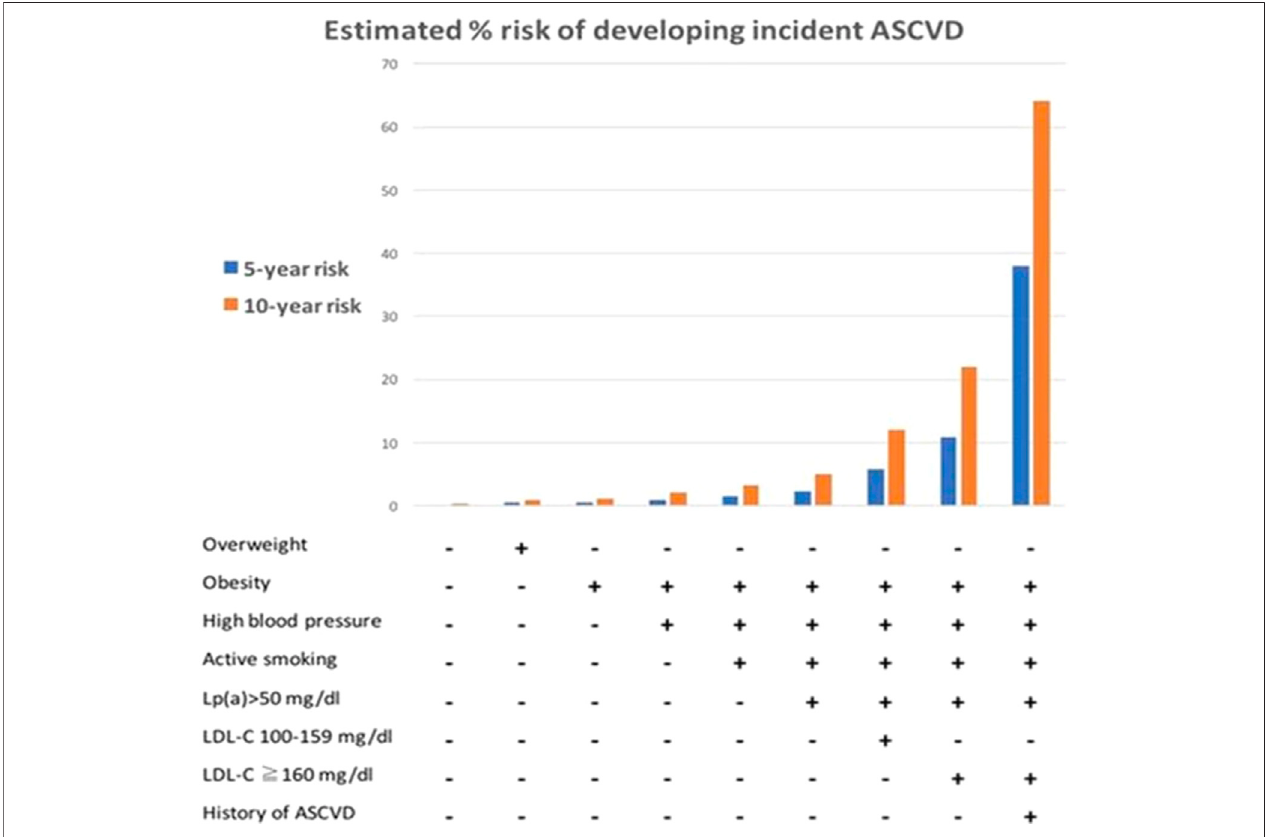
FIGURE 2 | Graphical use of SAFEHEART-RE for predicting 5 and 10-year risks of developing incident atherosclerotic cardiovascular disease (ASCVD) in familial hypercholesterolemia (FH) in primary prevention or secondary prevention settings; an example shown refers to a 66-year-old man with FH and low-density lipoprotein- cholesterol (LDL-C) < 100 mg/dl (2.6 mmol/L) in absence or presence of elevated lipoprotein (a) [Lp(a)] > 50 mg/dl. From Perez de Isla L et al. Predicting Cardiovascular EventsinFamilialHypercholesterolemia:TheSAFEHEARTRegistry(SpanishFamilialHypercholesterolemiaCohortStudy).Circulation.2017;135:2133 – 2144,with permission.